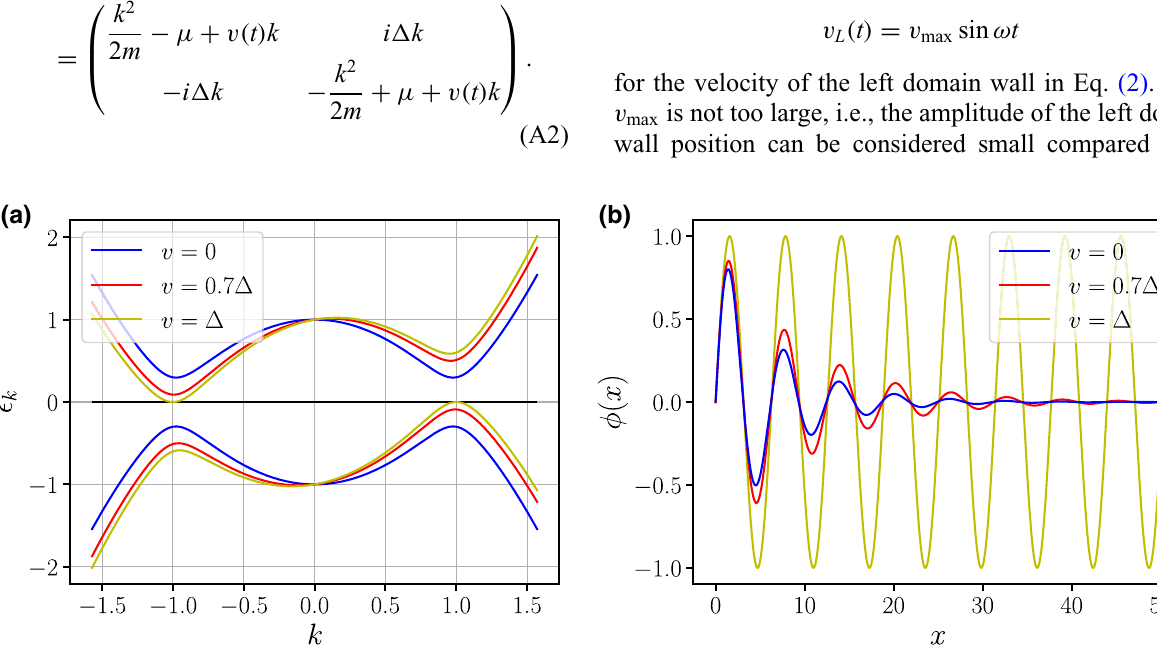
FIG. 9. (a) Mode dispersion in the moving frame for several different velocities. (b) Localization of the Majorana zero modes in the moving frame for several different velocities. It can be seen that the gap closes for v = v crit = (cid:3) and simultaneously the Majoranas delocalize in the moving